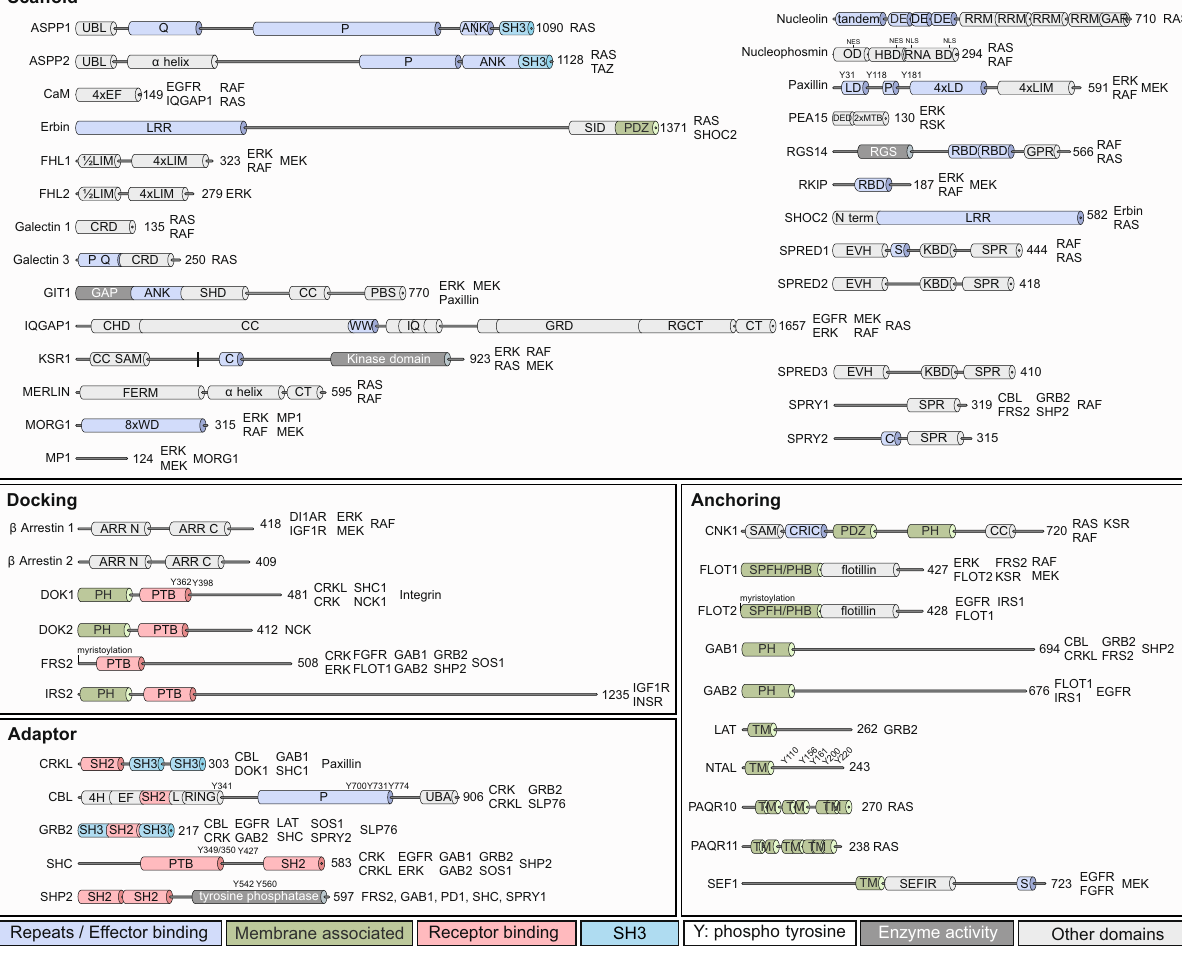
Fig. 1 Domain organisation and crucial interactions of RTK-RAS-MAPK accessory proteins. Schematic representation of relevant domains in scaffold, docking, adaptor and anchoring proteins. Direct binding partners, which are part of the RTK-RAS-MAPK pathway, are mentioned next to the amino-acid numbers at the right side of the proteins. Please check the list of abbreviations in the supplemental table for more details. Abbreviations are summarised in Supplementary Table